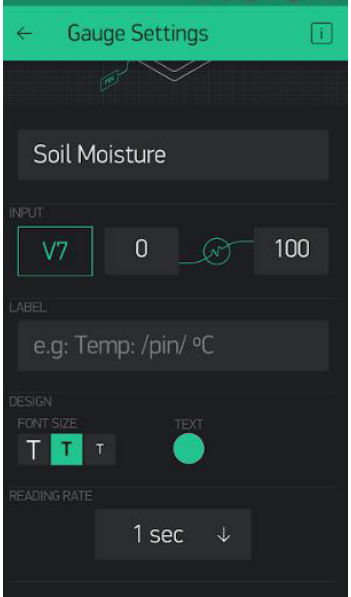
Figure 21. Blynk Gauge